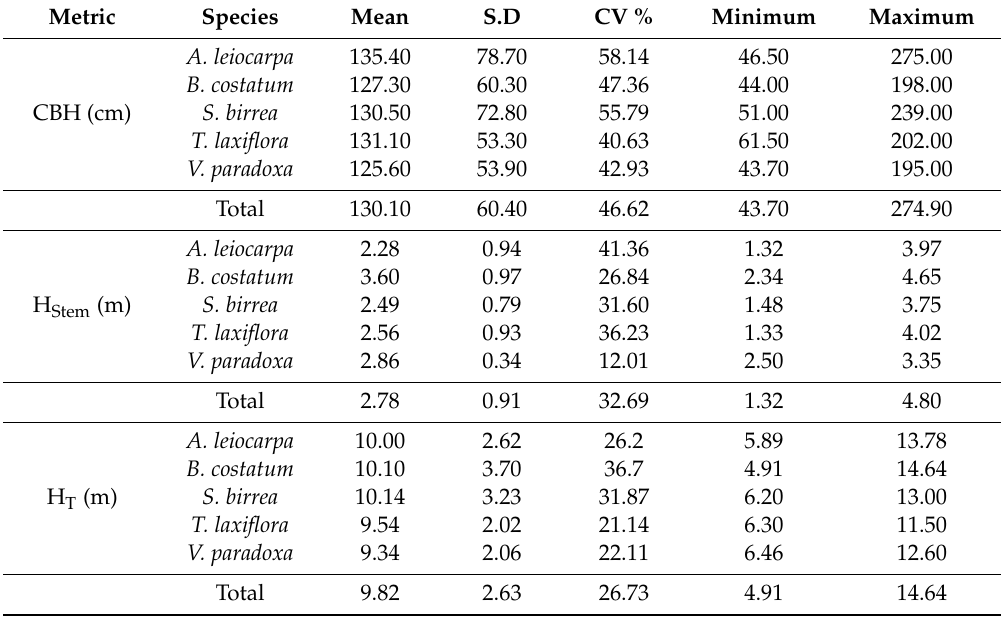
Table 1. Descriptive statistics of the sampled